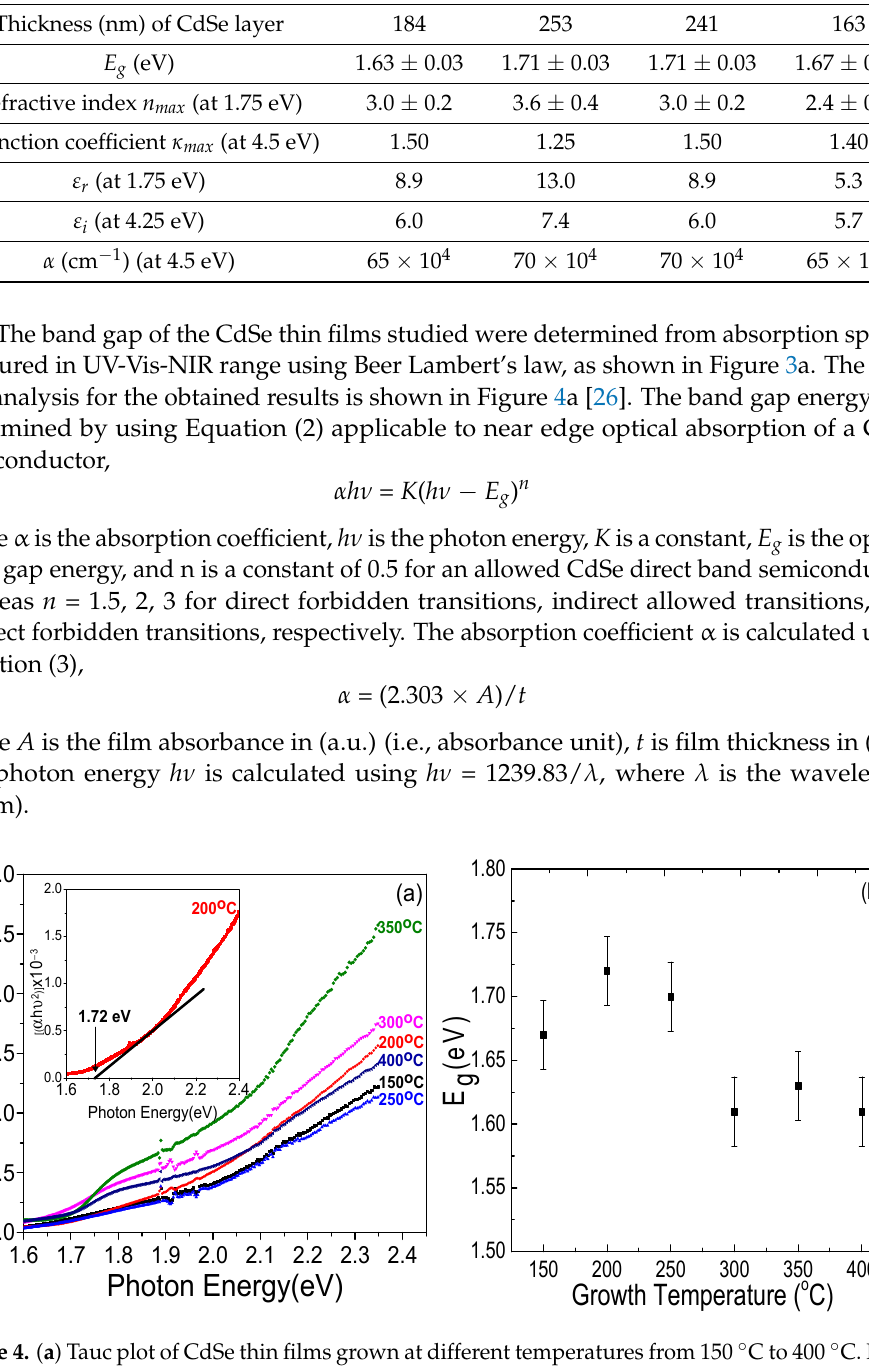
Figure 4. ( a ) Tauc plot of CdSe thin films grown at different temperatures from 150 °C to 400 °C. Insert shows the example of fitting outcome for CdSe sample grown at 200 °C. ( b ) Growth temperature vs. E g band gap energy obtained from ( a ).